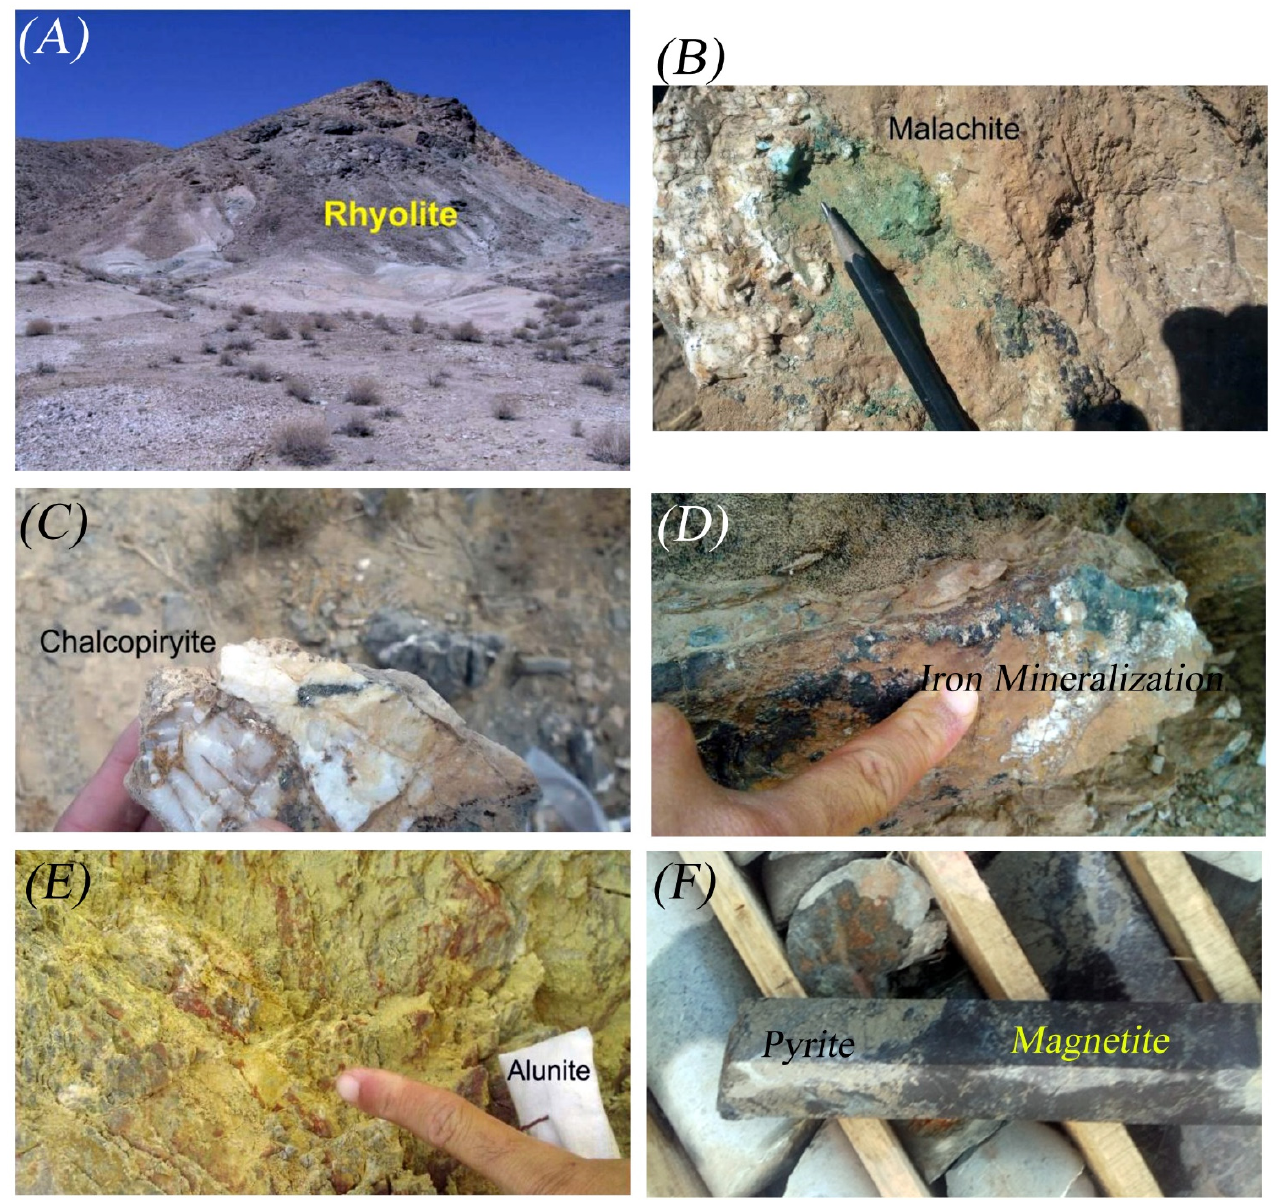
Figure 12. Field photographs of alteration and mineralization in the study area. ( A ) Rhyolitic tuffs comprise the alterations zones associated with iron oxides and feldspars; ( B ) Malachite surface expression in the oxidation zone; ( C ) Chalcopyrite surface expression in the oxidation zone; ( D ) Iron mineralization interlayer within rhyolites and acidic tuffs; ( E ) Alunite in iron oxides; ( F ) Pyrite and magnetite mineralization in the cores.